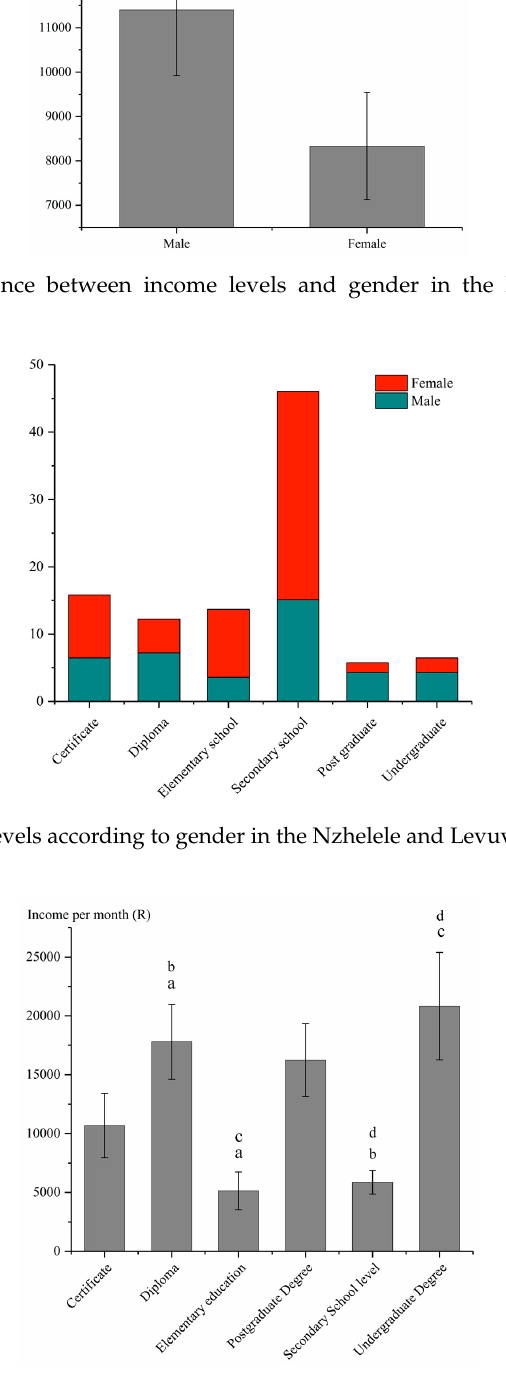
Figure 7. Correspondence between education levels and income in the Nzhelele and Levuvhu river catchments.